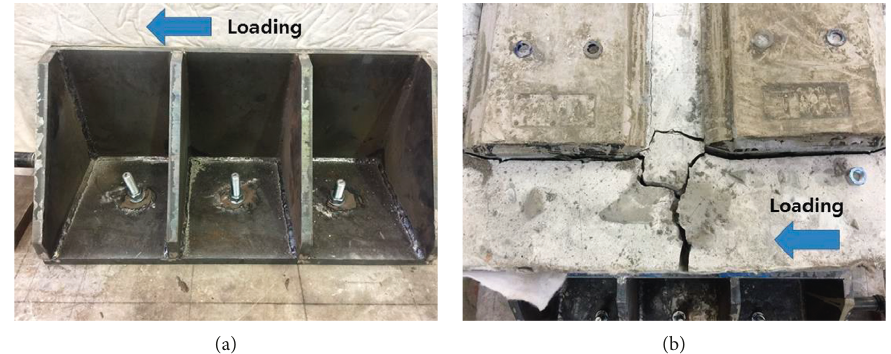
Figure 11: Failure of the specimen under the longitudinal load, Specimen AL: (a) damage on the anchor bolts and (b) crack pattern in concrete track.